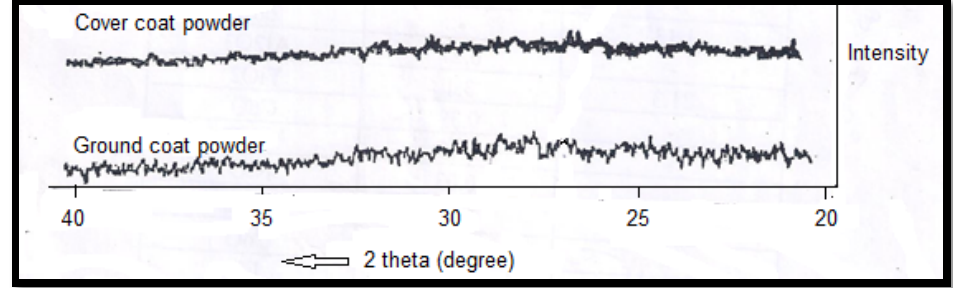
Fig.1: X-ray diffraction spectrum for ground coat and cover coat powder.